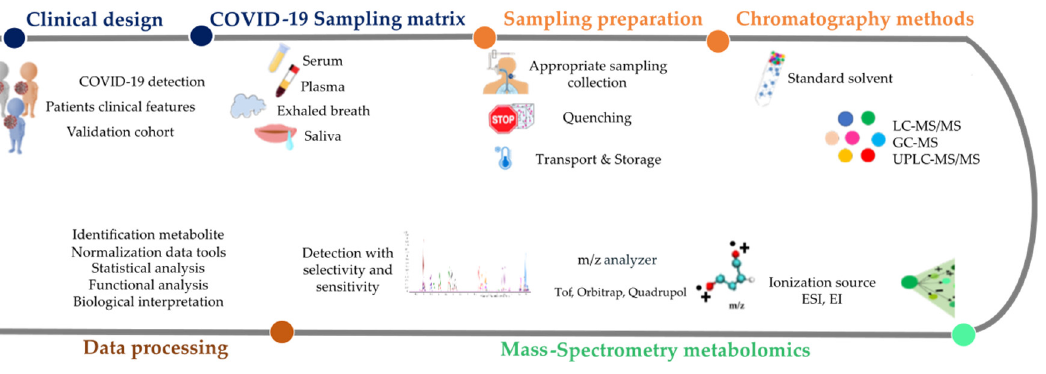
Figure 1. Metabolomics workflow to guideline towards a prognostic biomarker of COVID-19 identified by mass spectrometry metabolomics. Abbreviations: SARS-CoV-2: Severe Acute Respiratory Syndrome Coronavirus-2; COVID-19: Coronavirus disease 2019.